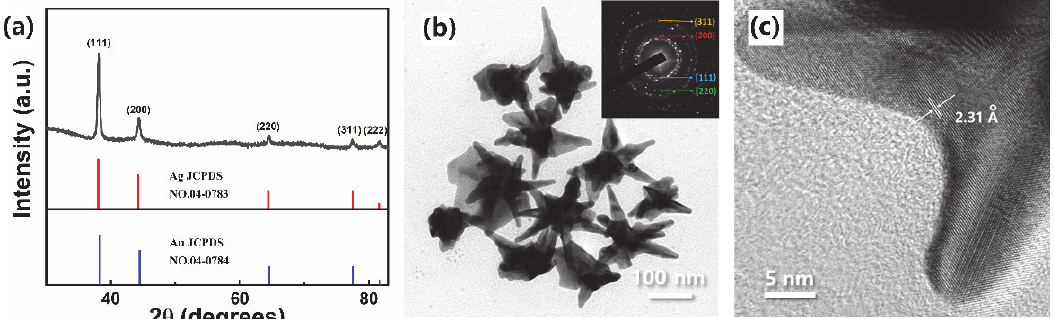
Figure 2. The XRD pattern ( a ), TEM image ( b ), inset was Fourier electron diffraction image, HR-TEM image ( c ), and Au-Ag nanostars synthesized with 50 mM LSB.